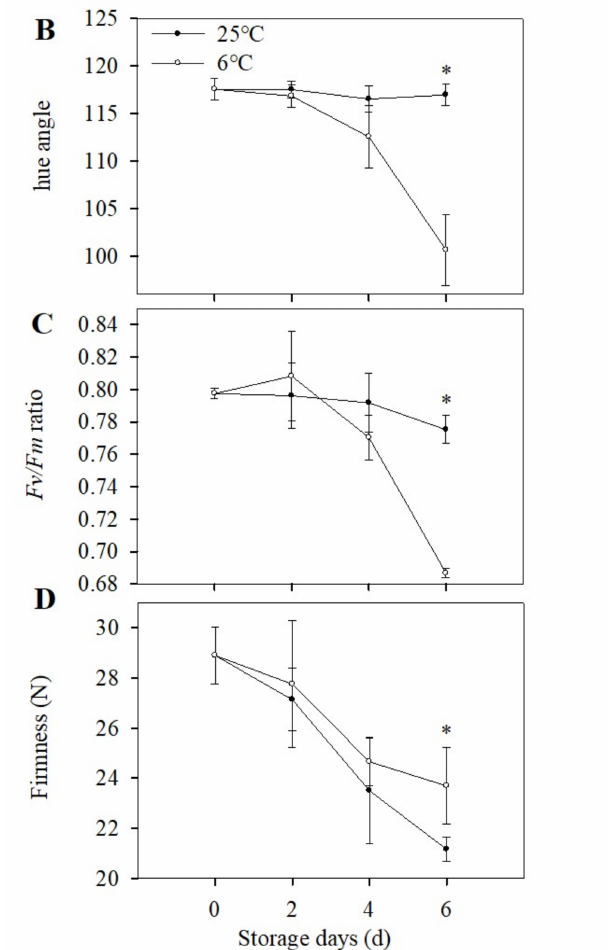
Figure 1. Chilling injury characteristics of banana fruit during storage at 6 ◦ C. Fruit stored at 25 ◦ C is the control. Changes in chilling injury phenotype ( A ), hue angle ( B ), Fv/Fm ( C ), and firmness ( D ) of banana fruit during storage. Each data point represents a mean ± standard error ( n = 3). ‘*’ means a significant difference between control and experimental fruit at the 5%